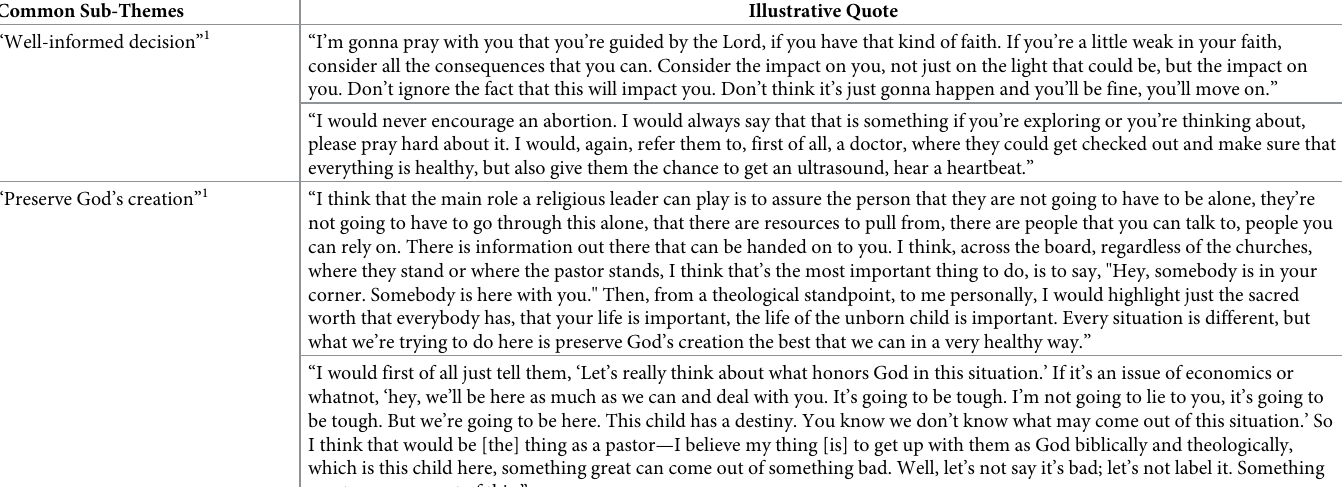
Table 4. Illustrative quotes for pastoral care sub-themes. Common